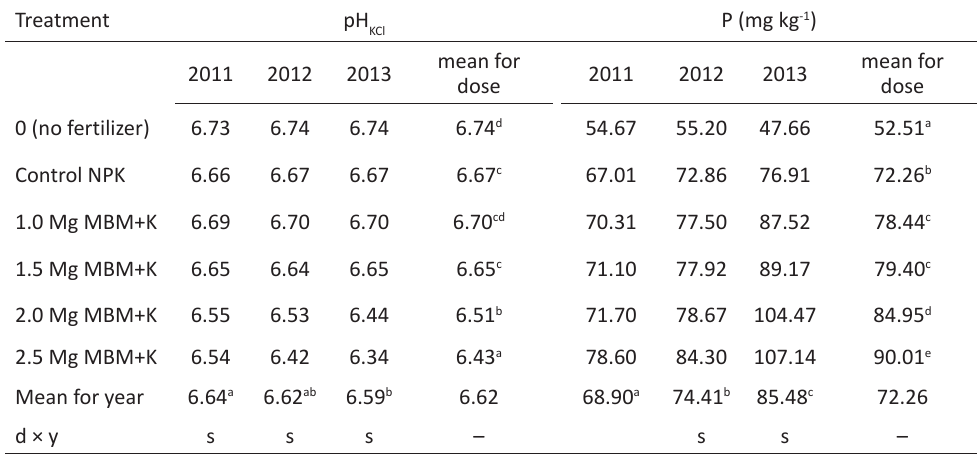
of soil and on the available phosphorus content of soil KCl